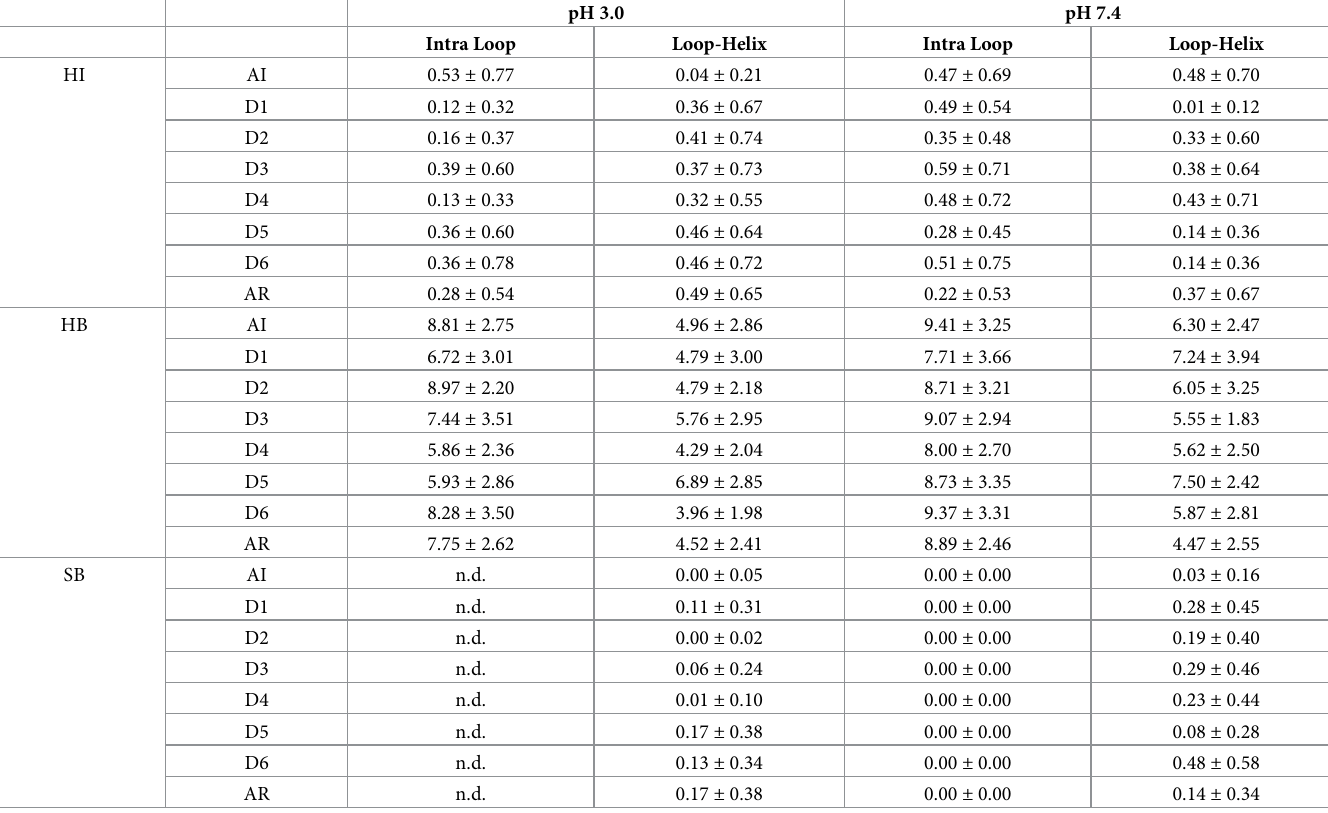
� The data is presented as an average taken across both of the monomeric units for each of the three replicates ( n = 6). The last 10% of the trajectories was utilized for the analyses. Error is standard